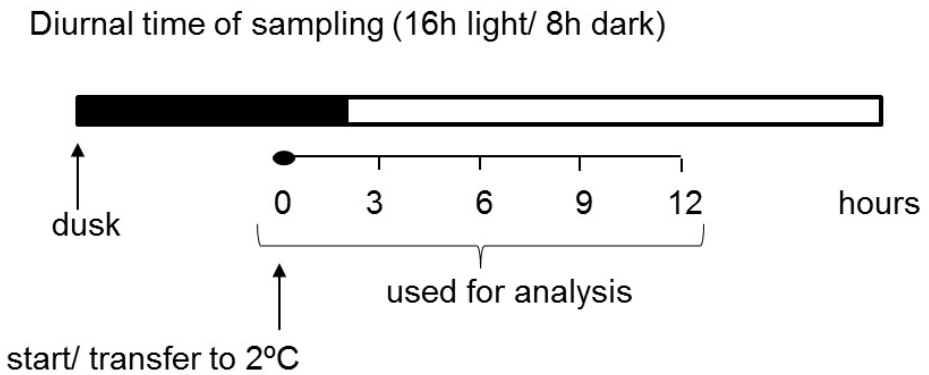
Figure 1. Experimental design of sampling.